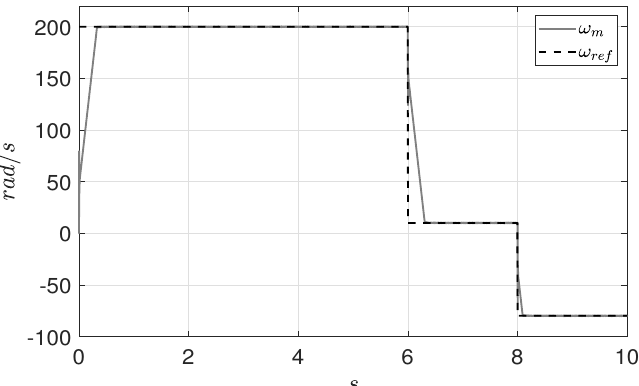
Figure 10. Rotor angular velocity reference signal ω ref and motor angular velocity ω m .